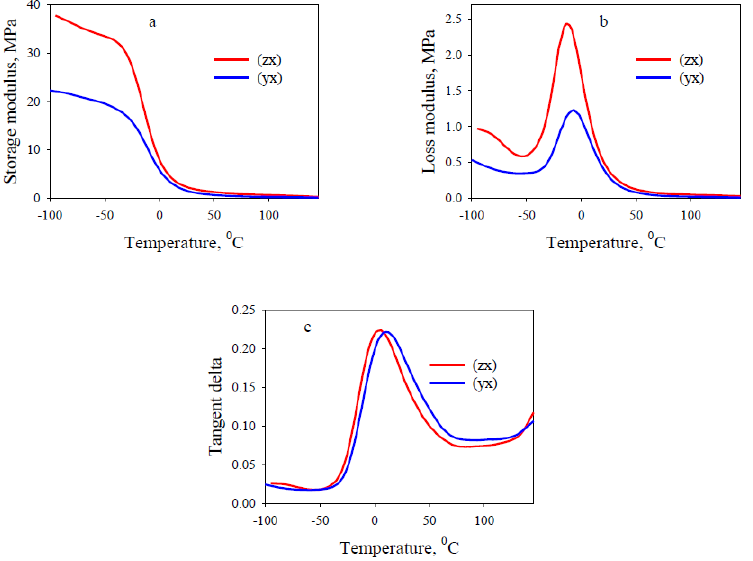
Figure 4. DMA curves for lattice flexible TPU with honeycomb architecture. ( a )– E’(T) , ( b )– E”(T) , ( c )–tg δ (T) dependencies. Table 2. Viscoelastic properties of lattice flexible